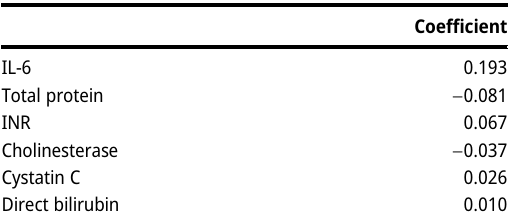
Table  : AMPEL MELD model coe ffi cients.